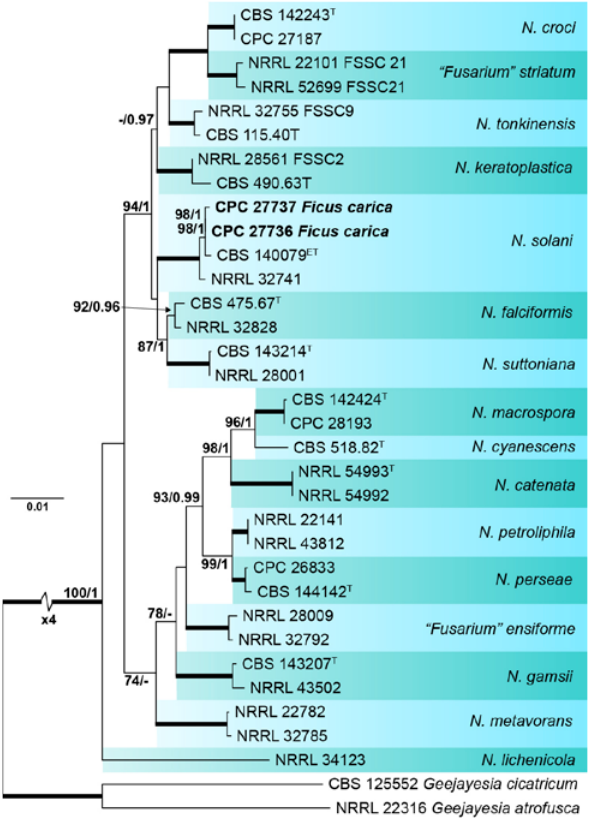
Figure 4. Maximum-likelihood (ML) phylogram of Neocosmos- pora (= Fusarium solani species complex) obtained from combined EF-1α , ITS, LSU and RPB2 sequences. Branch lengths are propor- tional to distance. Numbers on the nodes are ML bootstrap values greater than 55%; and Bayesian posterior probability values greater than 0.95. Full supported branches and isolates obtained from orna- mentals plants are indicated in bold. Ex-type and ex-epitype strains are indicated with T and ET